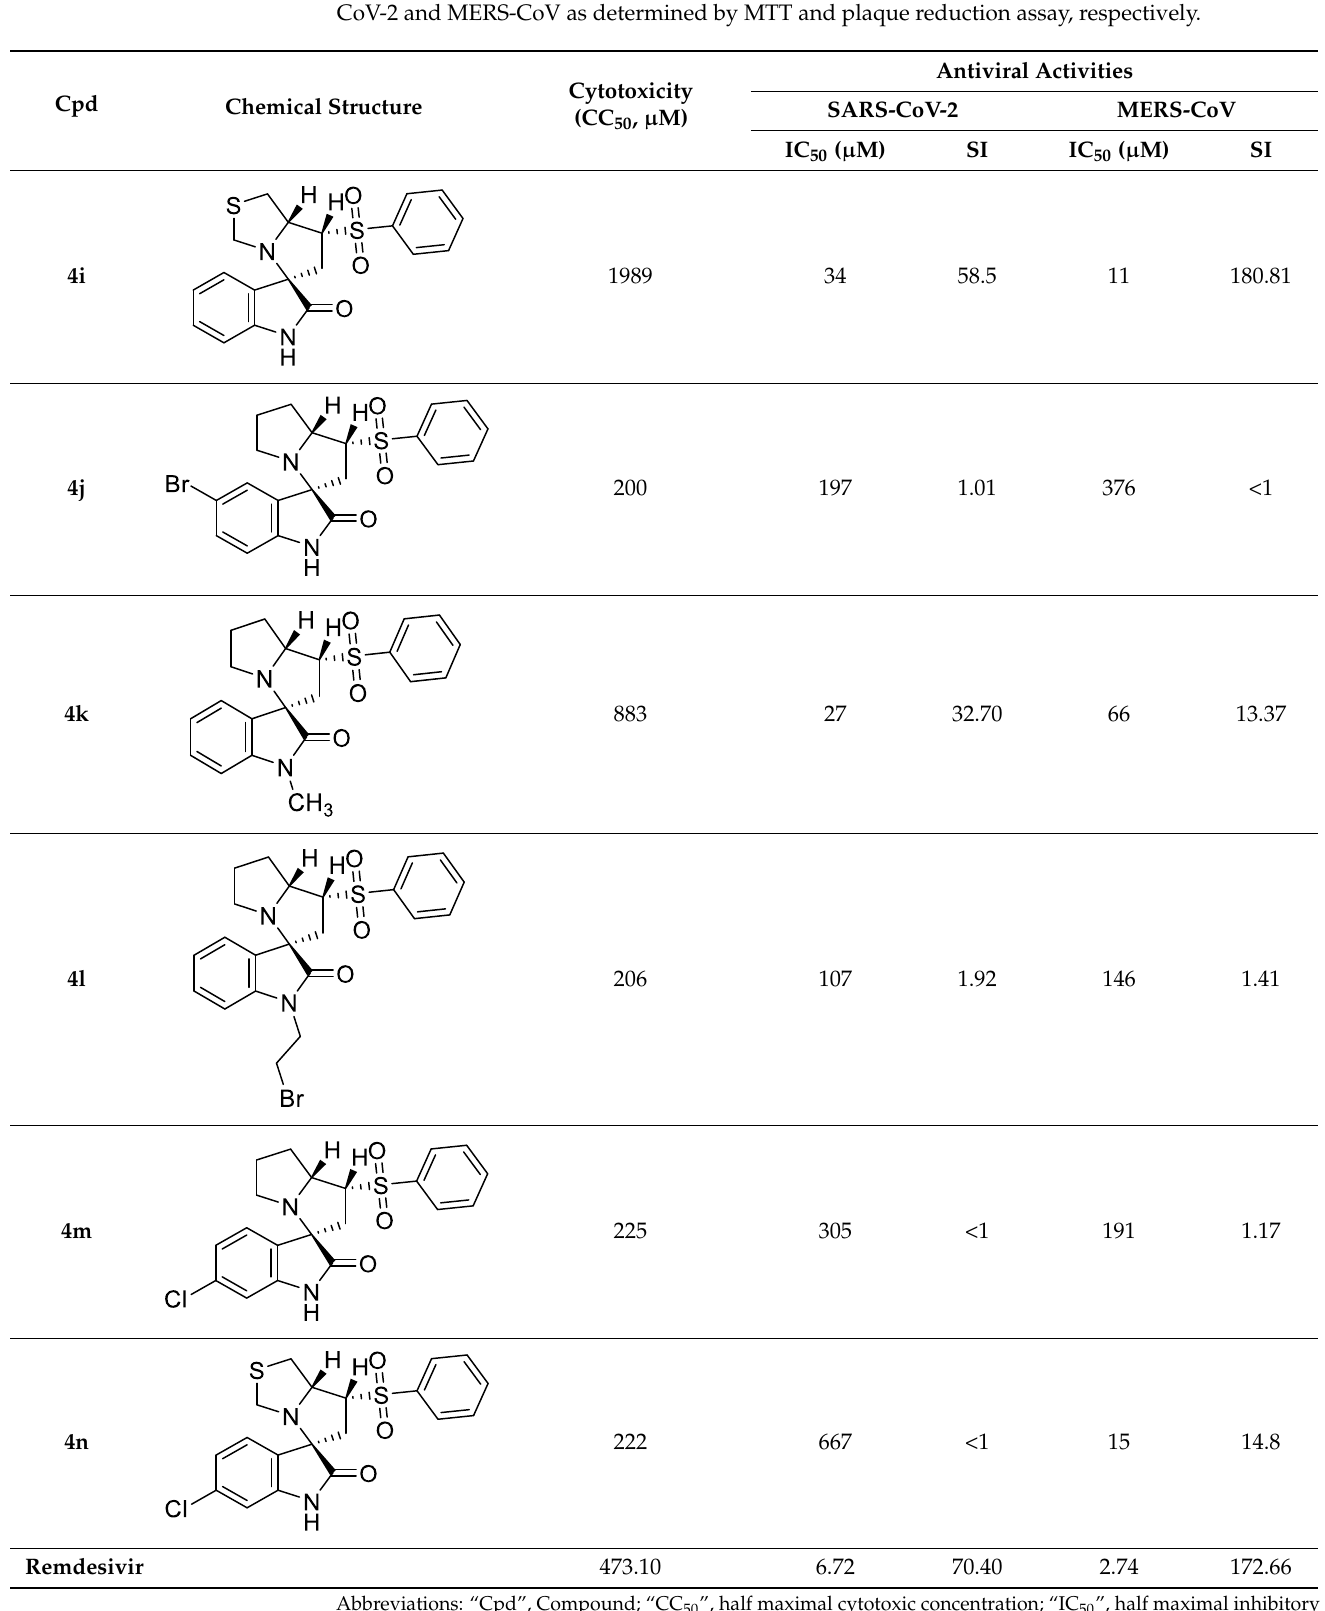
Table 3. Chemical structures, cytotoxicity, antiviral activities of the tested compounds against SARS- CoV-2 and MERS-CoV as determined by MTT and plaque reduction assay, respectively.